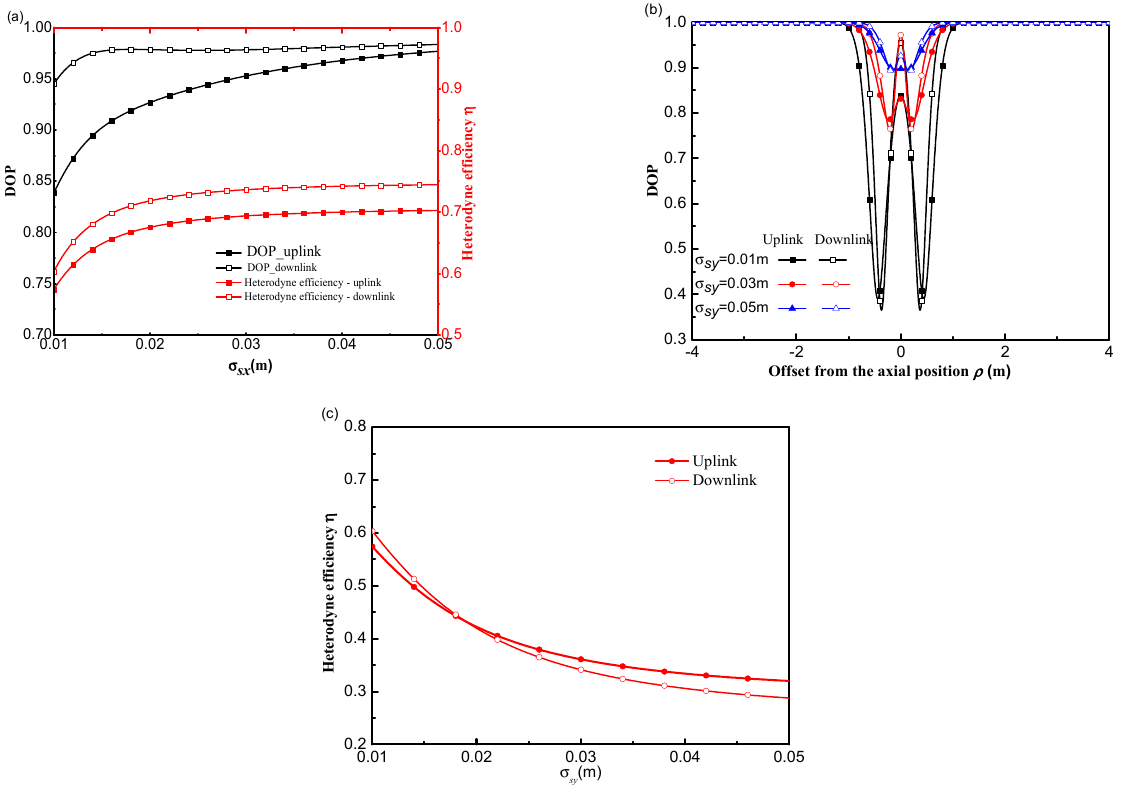
Figure 2. Effect of waist radius of signal beam on the DoP and heterodyne efficiency of an uplink path and a downlink path in atmospheric turbulence ( a ) σ sx , ( b ) offset from the axial position ρ and ( c ) σ sy .